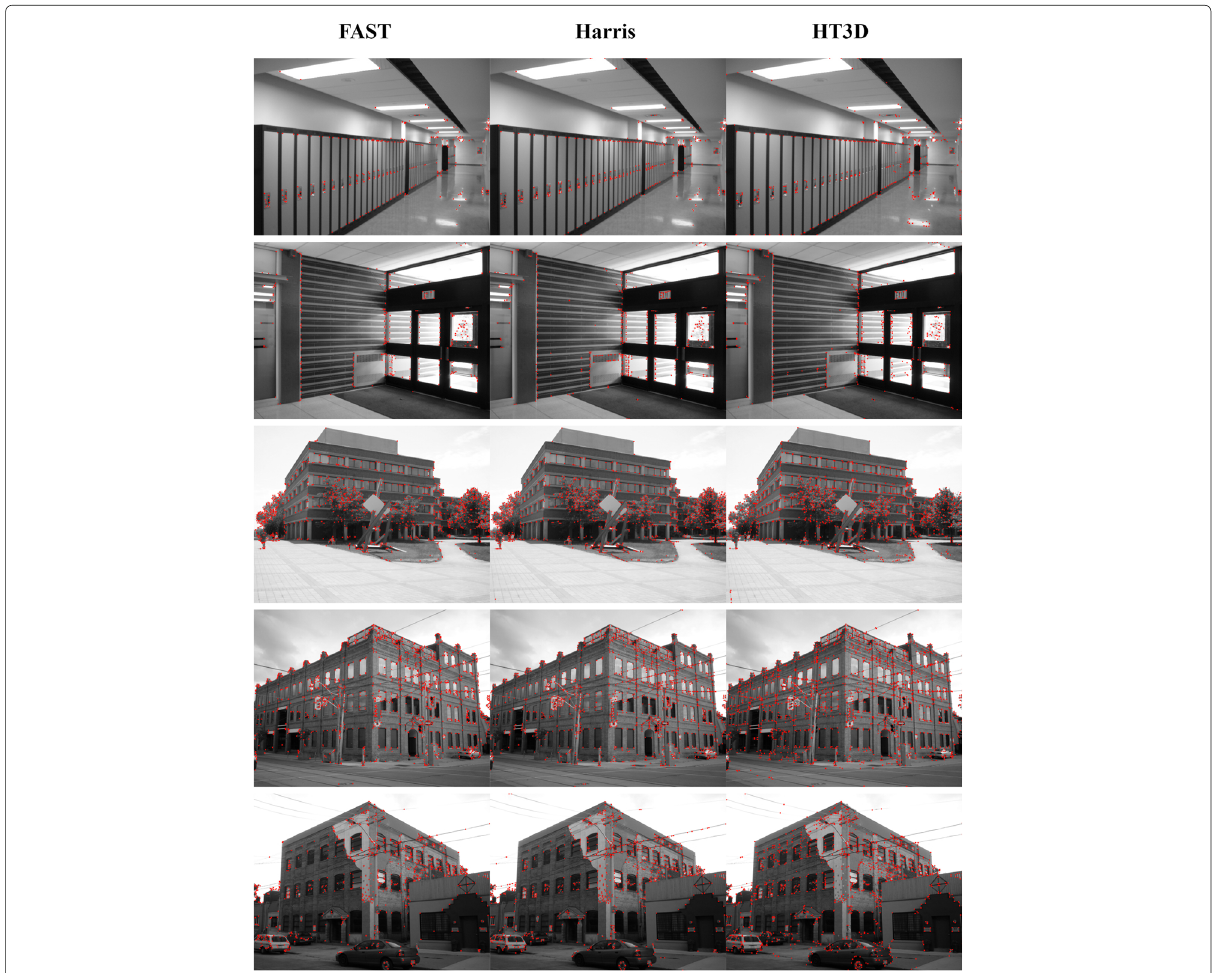
Fig. 13 Detected corners and endpoints for the first set of